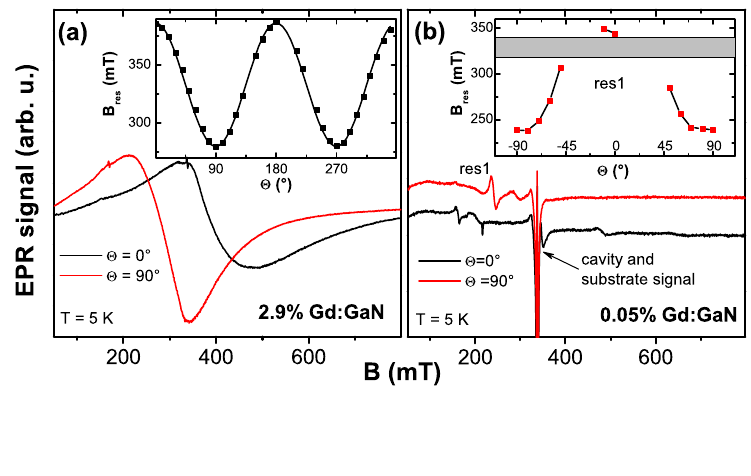
Figure 19. EPR measurements as a function of the polar angle (cid:2) at X-band frequency and 5 K for the (a) 2.9% and (b) 0.05% Gd samples, respectively. (a) A broad resonance line with uniaxial angular dependence (see inset) is visible for the 2.9% Gd sample. (b) The 0.05% Gd sample shows various weak signals; the most prominent line (labeled “res1”) shows a uniaxial behavior as well (see